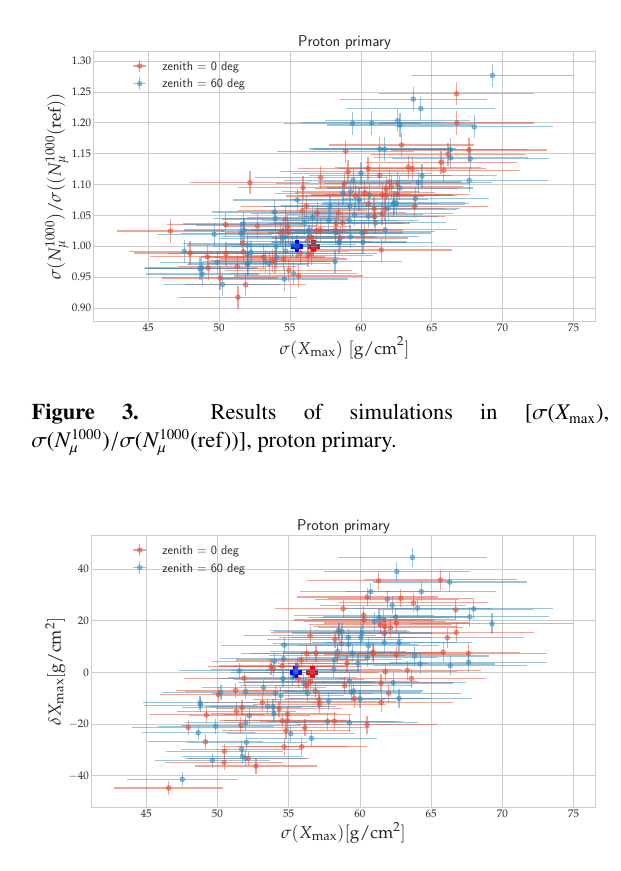
Figure 4. Results of simulations in [ σ ( X max ), δ X max ], proton pri- mary.